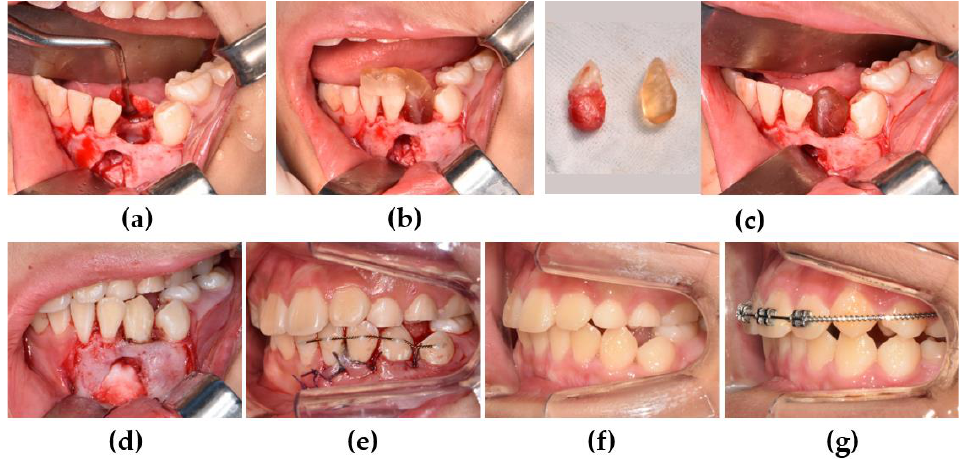
Figure 3. Autotransplantation of impacted left mandibular canine (Case 1): Surgical procedure ( a – e ). The shape and size of the 3D-printed replica is similar to those of the real extracted canine. The clinical condition at the 3-month ( f ) and 18-month follow-up ( g ) is shown.